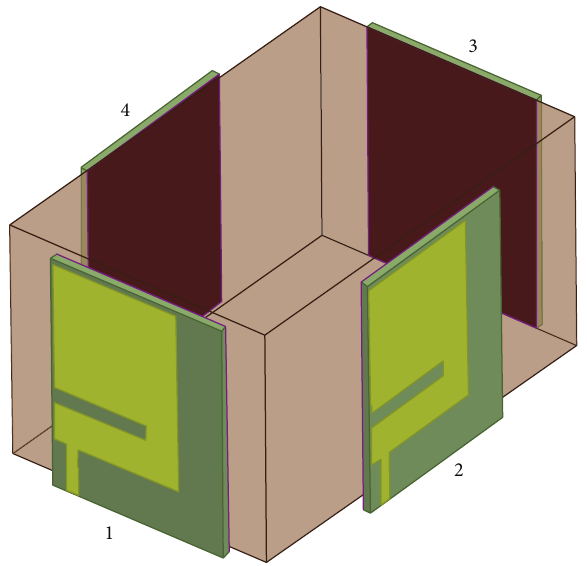
Figure 6: Multielement antenna